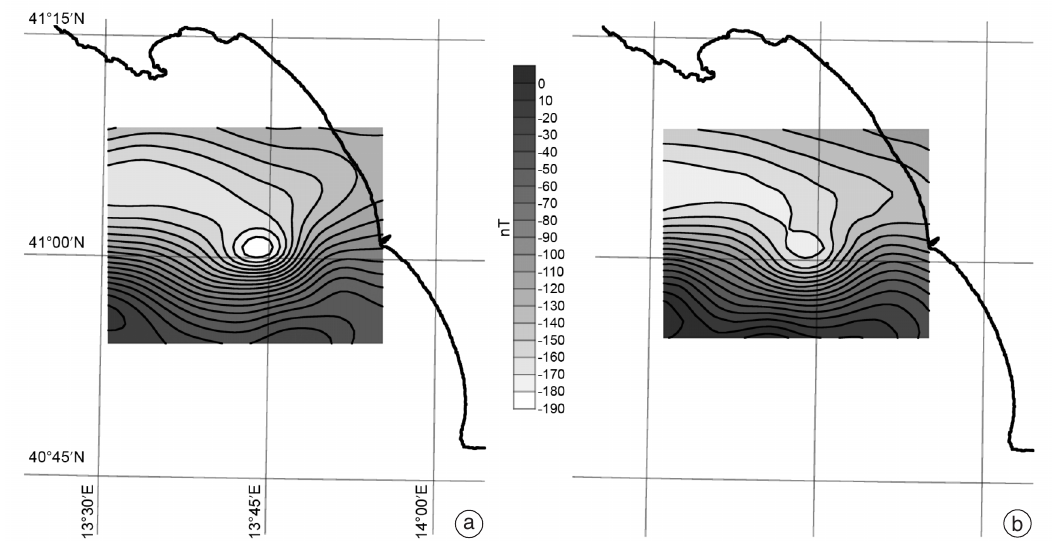
Fig. 7a,b. a) Upward continuation of the sea level magnetic anomaly field and comparison with b) aeromag- netic data acquired at the same altitude (2600 m a.s.l.). Scale in